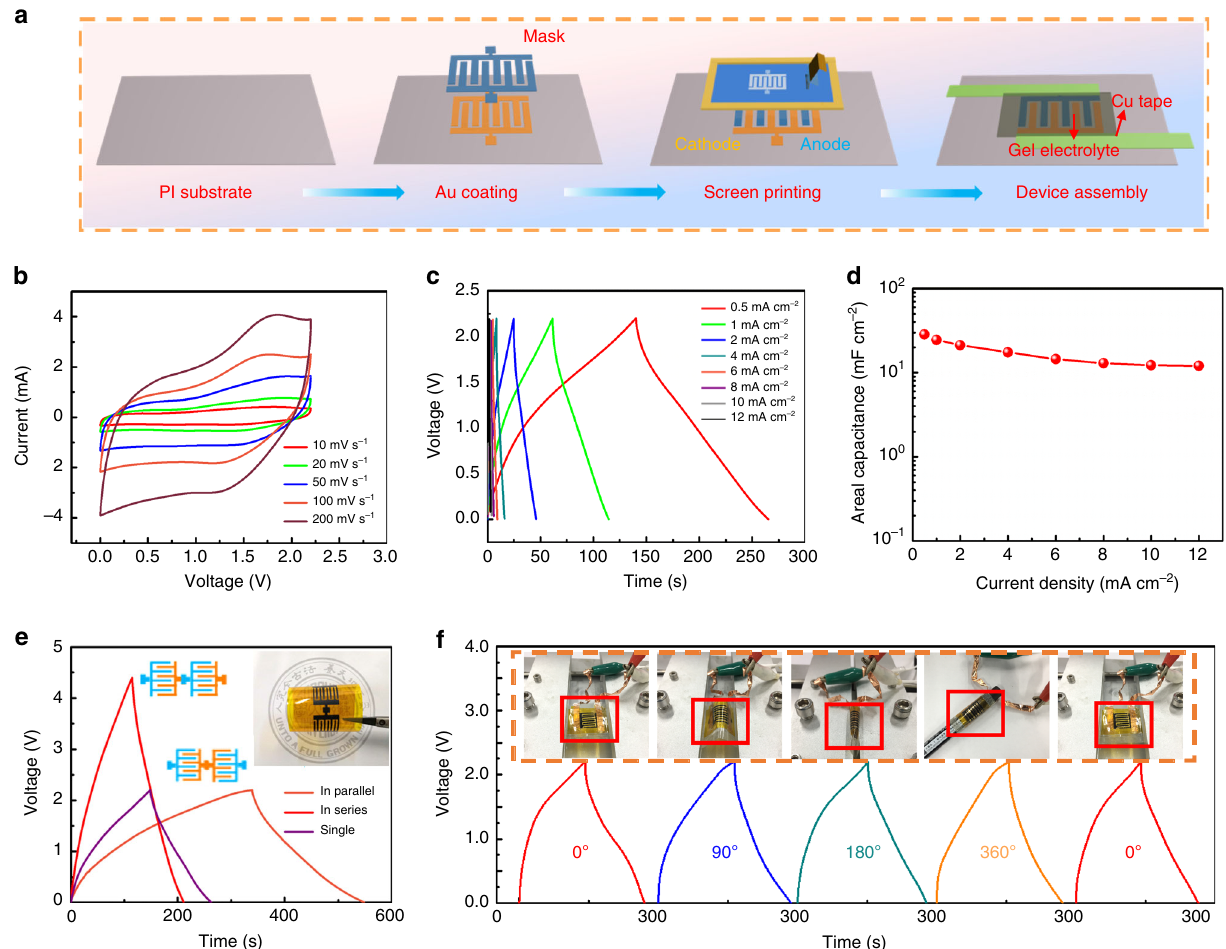
Fig. 5 Electrochemical performance of a fl exible and printable quasi-solid-state MASC. a Schematic illustration of the fabrication process of a MgSO 4 /PAM VN//MnO 2 MASC. b CV curves of a printed MASC obtained at different scan rates. c Galvanostatic charge/discharge curves tested at different current densities. d Calculated areal speci fi c capacitance at different current densities corresponding to c . e Galvanostatic charge/discharge curves obtained at 0.5 mA cm − 2 of single, series and parallel connections of two MASCs. f Galvanostatic charge/discharge curves tested at 0.5 mA cm − 2 under